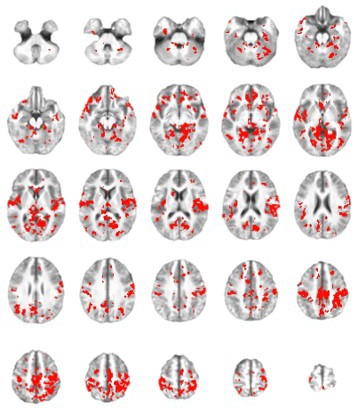
Selective effects of stimulation on memory-specific connectivity.All regions showing a significant three-way interaction between condition, demand, and group. Red coloration indicates supra-threshold voxels with positive differences (retrieval stimulation effect > rest stimulation effect) and blue coloration indicates negative differences (rest stimulation effect > retrieval stimulation effect).